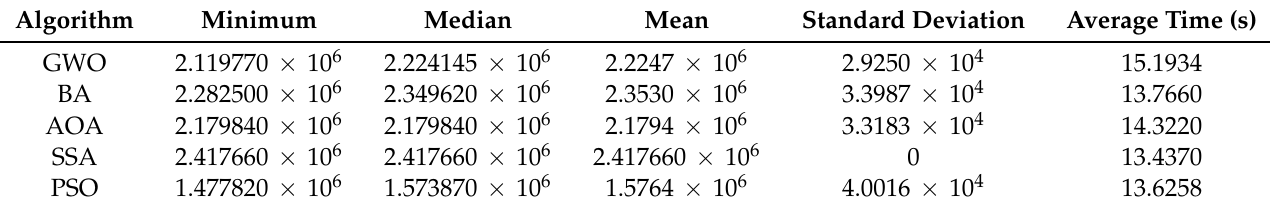
Figure 14. Boxplots of the optimal fitness values from the 250 simulations. Table 4. Comparison of fitness values obtained by metaheuristics and average execution time.